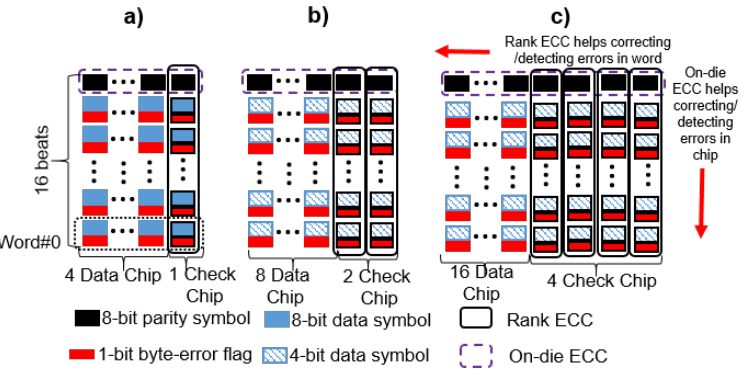
Figure 5. A visualization of all OBET-based techniques for the ( a ) SECDED, ( b ) Chipkill-SSC, and ( c ) Chipkill-SSCDSD